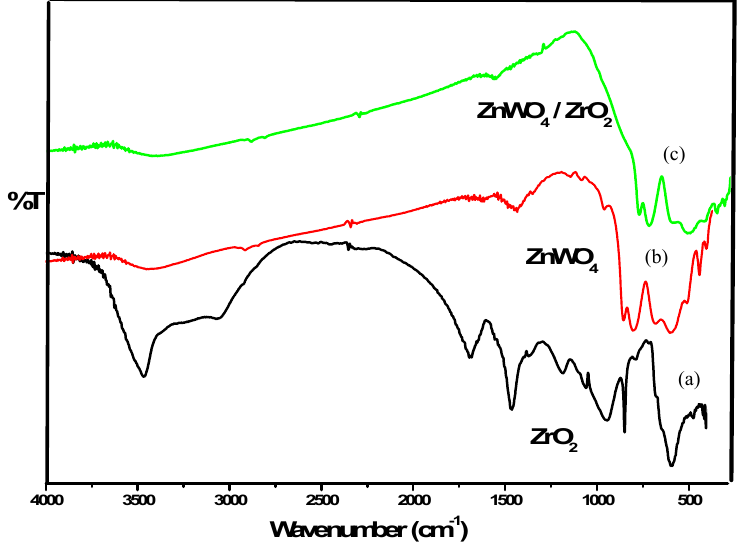
Fig. 2. FT-IR spectra of ZrO